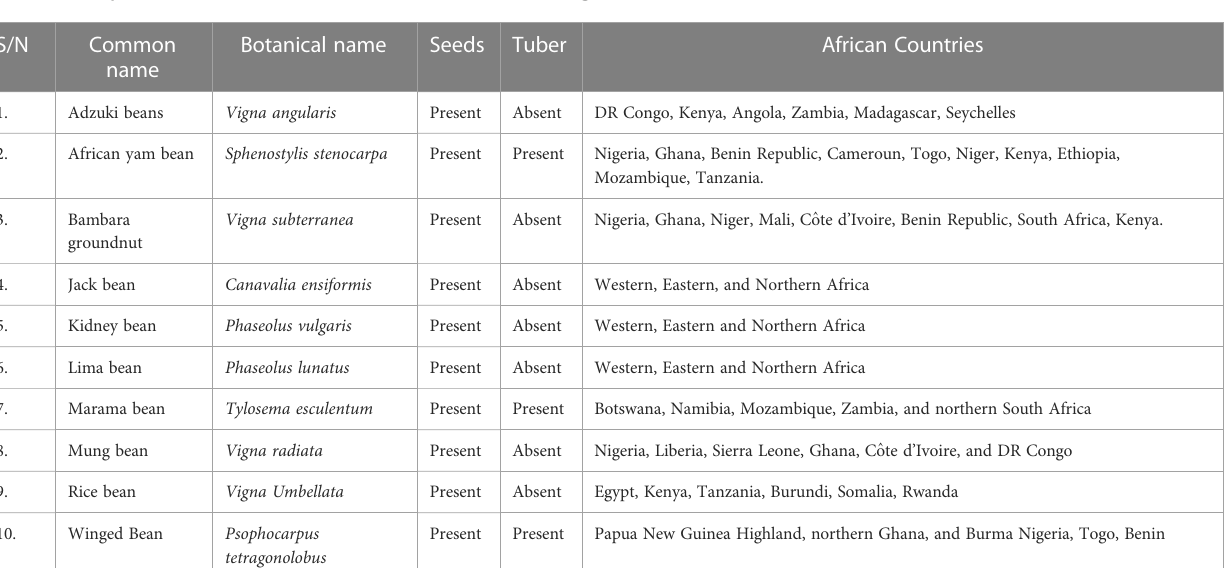
TABLE 1 Plant products and distribution of the selected underutilized legumes in